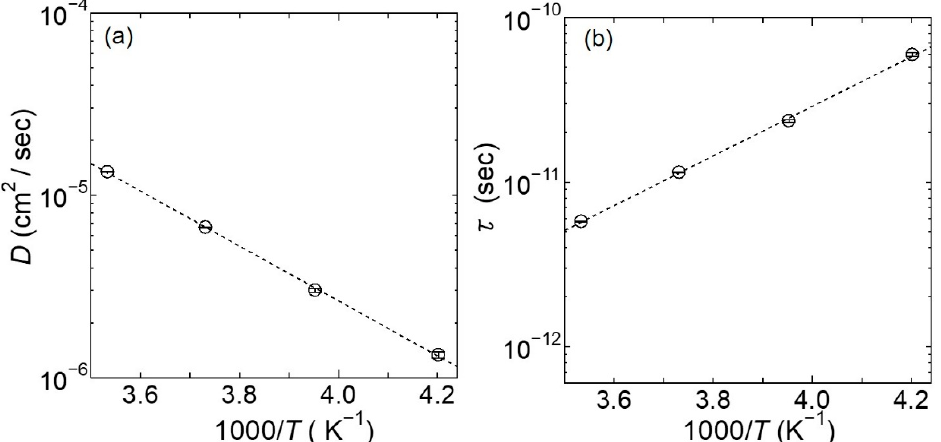
Figure 13. Arrhenius plots of ( a ) D and ( b ) τ for the mobile hydrogen atoms at 238, 253, 268, and 283 K obtained as fitting parameters from the analysis based on the jump-diffusion model for Γ hydrogen atom . The black dotted lines in plots ( a , b ) represent the results fitted by the Arrhenius Equation. The errors estimated from the fitting procedure are indicated by bars.